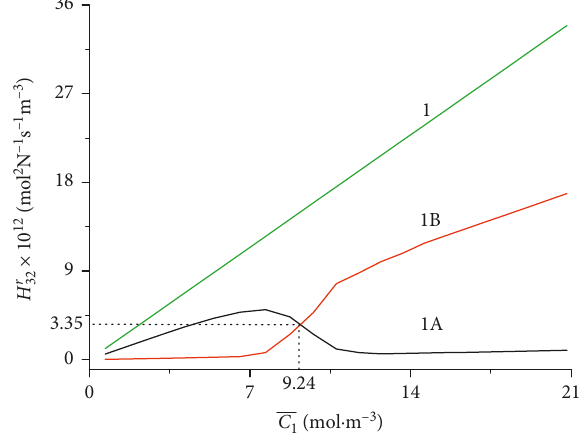
Figure 7: The graphic illustration of the dependence H r 3 ) ( r C A, B) for the glucose in aqueous ethanol 2 (cid:31) 37.71mol · m (cid:31) solution in conditions of concentration polarization for configu- − rations A ( H A f ( C 1 , C 2 const.), curve 1A) and B ( H B 32 (cid:31) (cid:31) C 2 (cid:31) const.), curve 1B) of the membrane system. Line 1 illustrates the dependence H 32 f ( C 1 , C 2 const.) in conditions of homo- (cid:31) (cid:31) geneity of solutions.